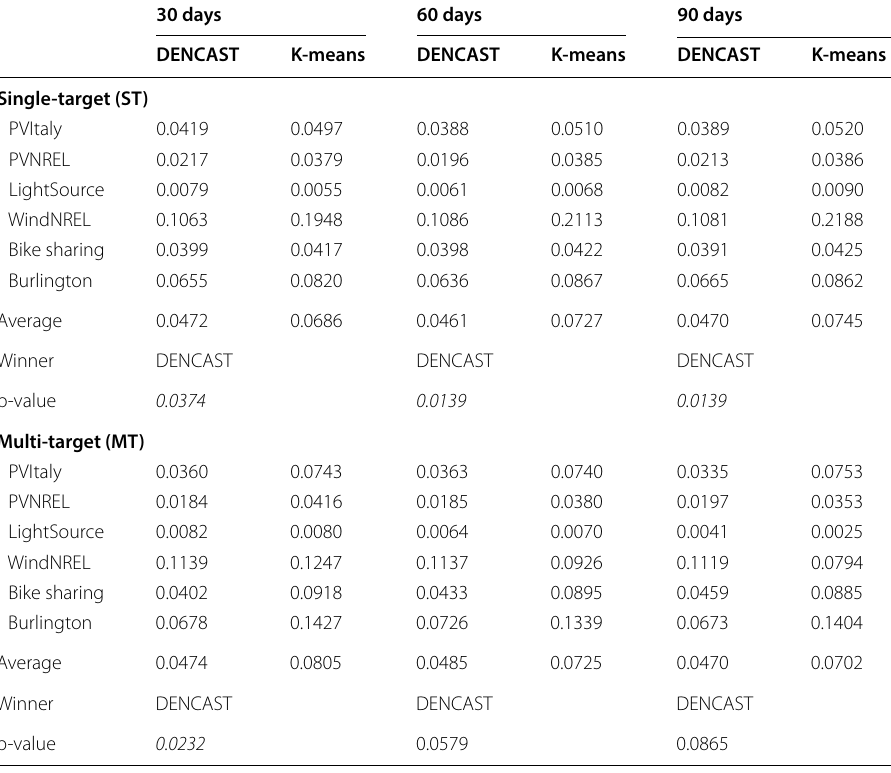
Statistically significant results are marked in